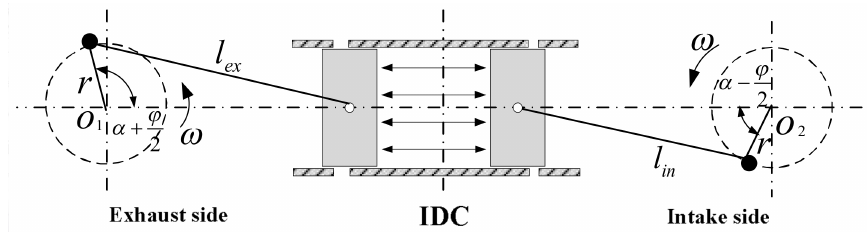
Figure 3. Opposed crank-connecting rod